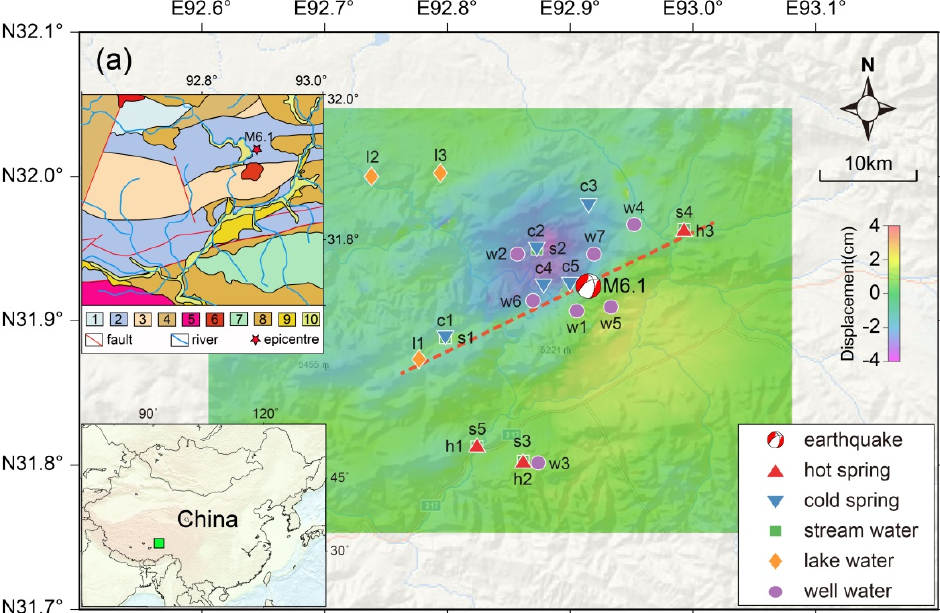
Figure 1. Epicenter of the 2021 Biru M6.1 earthquake and distribution of hydrochemical sampling sites. The color-filled areas show the interferograms of coseismic ground deformation. The red dotted line shows the speculative seismogenic fault of this earthquake. The lithology of the strata in the geological map legend is as follows, 1: Precambrian dolomite; 2: Permian schist; 3: Jurassic schist; 4: Jurassic limestone and slate; 5: Late Cretaceous quartz diorite; 6: Late Cretaceous granites; 7: Cretaceous sandstone; 8: Cenozoic sandstone; 9: Pleistocene clay; 10: Holocene clay.